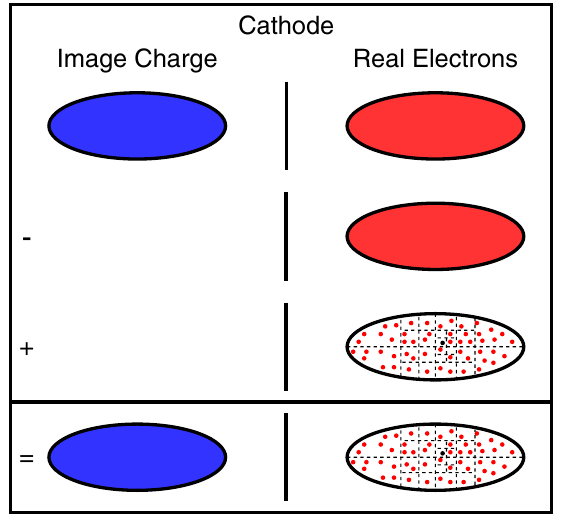
FIG. 1. Depiction of PMP three-step space charge calculation. Filled in ellipses represent mean-field calculation of electric fields, and ellipses filled with dots represent a Barnes-Hut calculation of electric fields.